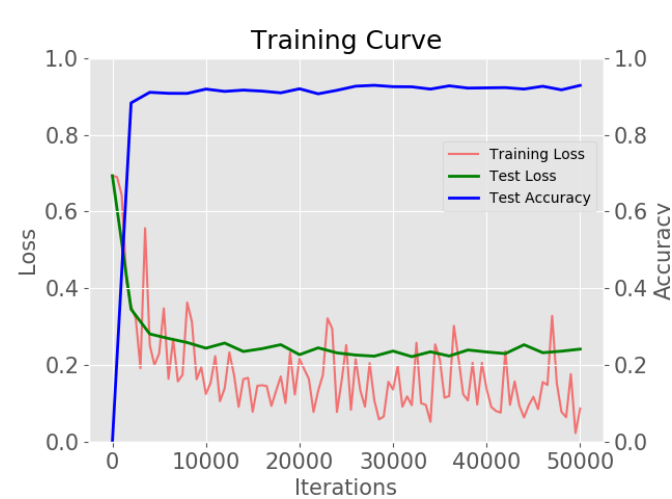
Figure 10. The overall training loss, test loss, and test accuracy of the proposed